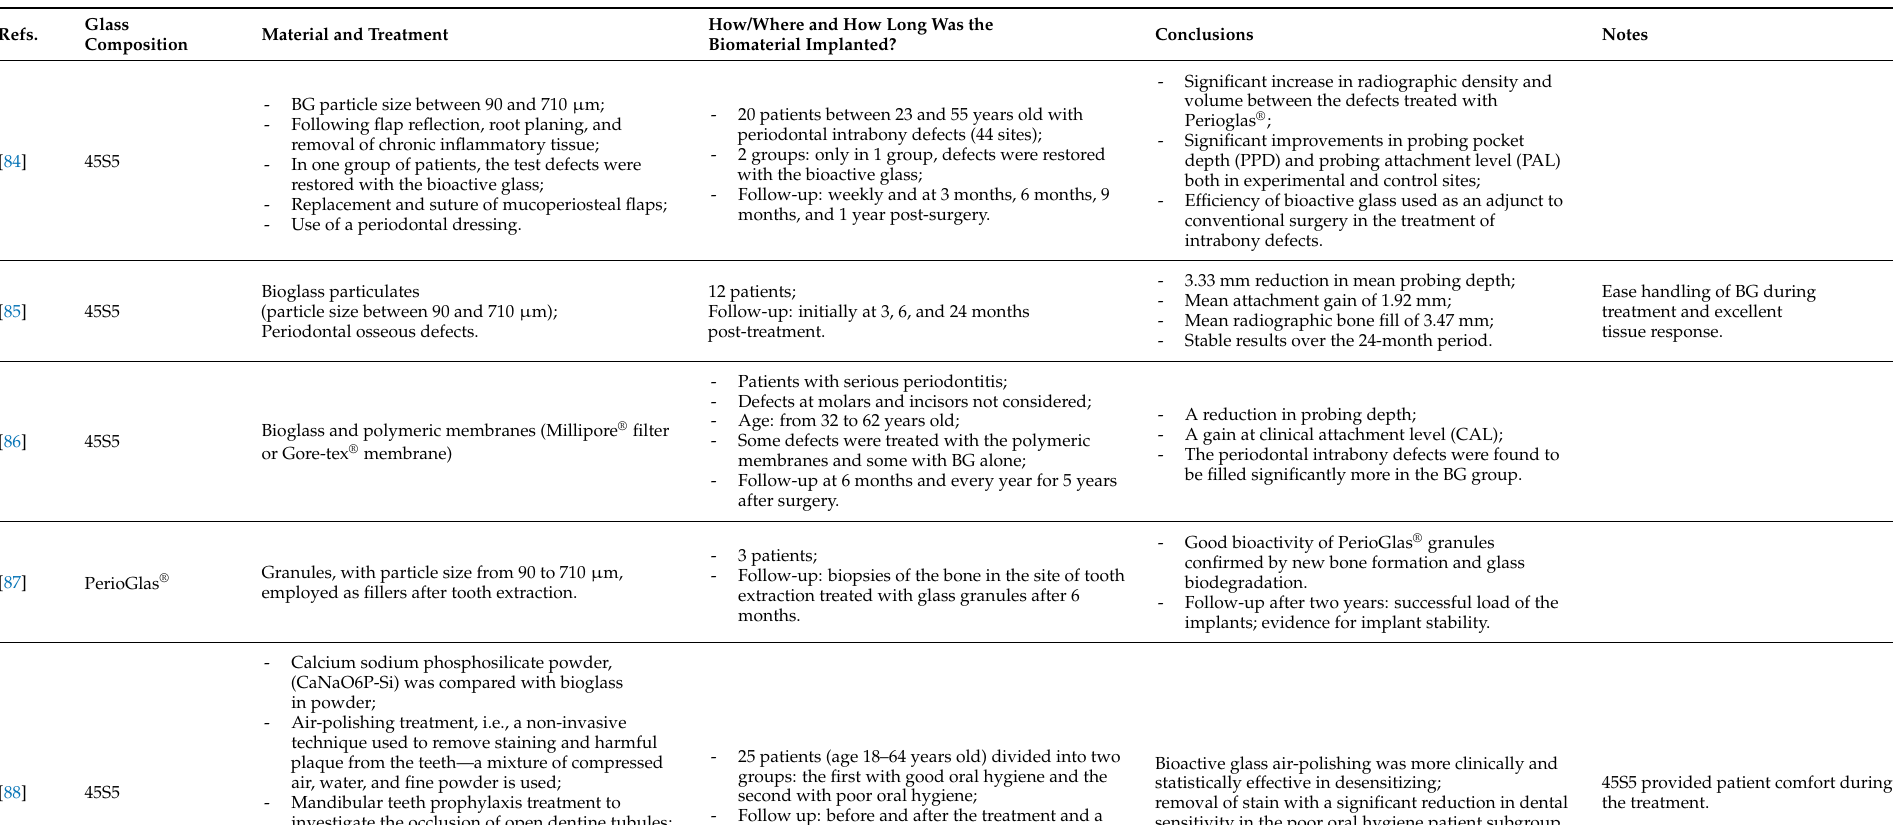
Table 2. The main clinical studies, performed in the field of dental and maxillofacial applications, based on the use of 45S5 and its derivate types (from 1997 to present).